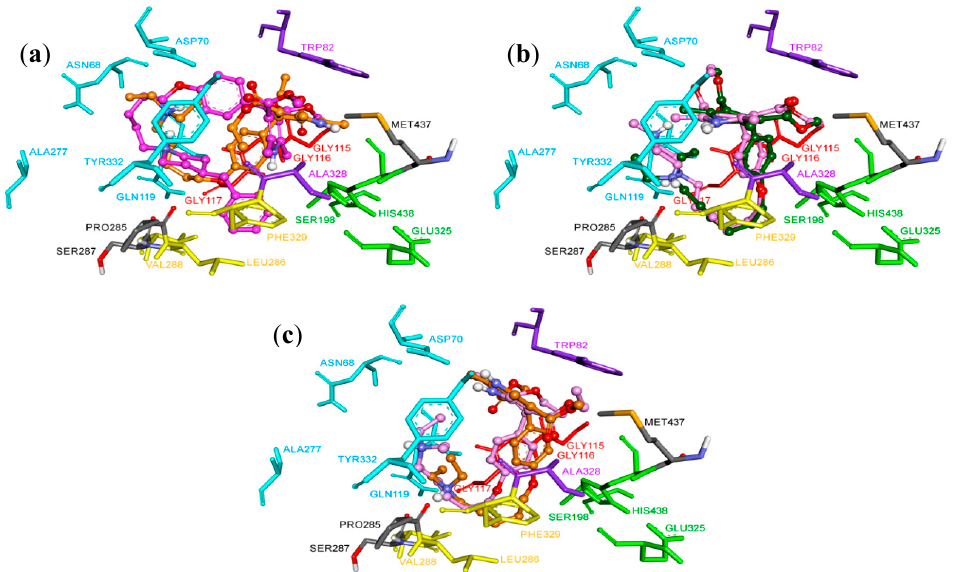
Figure 5. Docking pose of compounds 3c , 3d , 3h and 3k-3m inside gorge cavity of hBuChE. ( a ) Compound 3h is shown in pink, compound 3c in orange. ( b ) Compound 3l is shown in green, compound 3m in light violet. ( c ) Compound 3d is shown in orange, compound 4k in light pink. All compounds are represented in ball and stick models, CAS in green, OH in red, CBS in violet, ABP in yellow, and PAS in